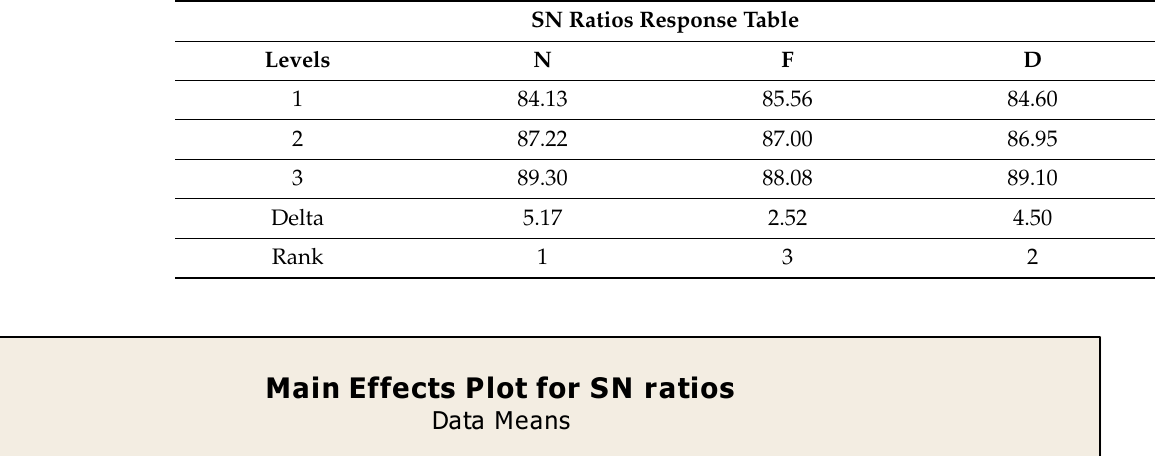
Table 4. Taguchi analysis details of MRR vs. speed (N), feed (F), and depth of cut (D).